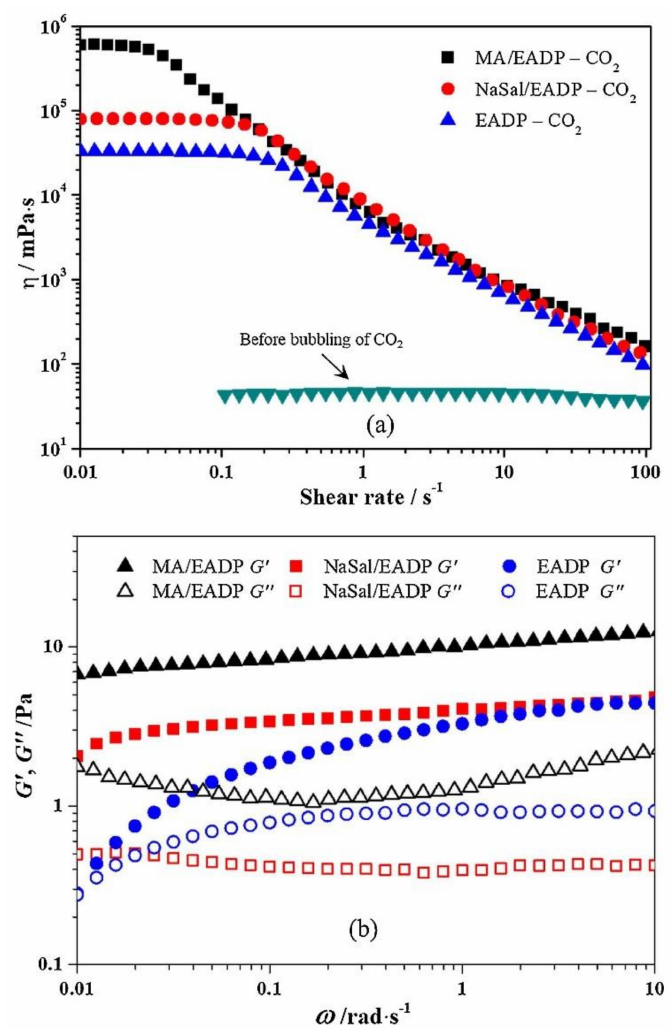
Figure 12. Shear viscosities in steady-state for 100 mM EADP aqueous systems with various additives ( a ); For EADP solutions with various additives, storage and loss modulus versus frequency ( b )